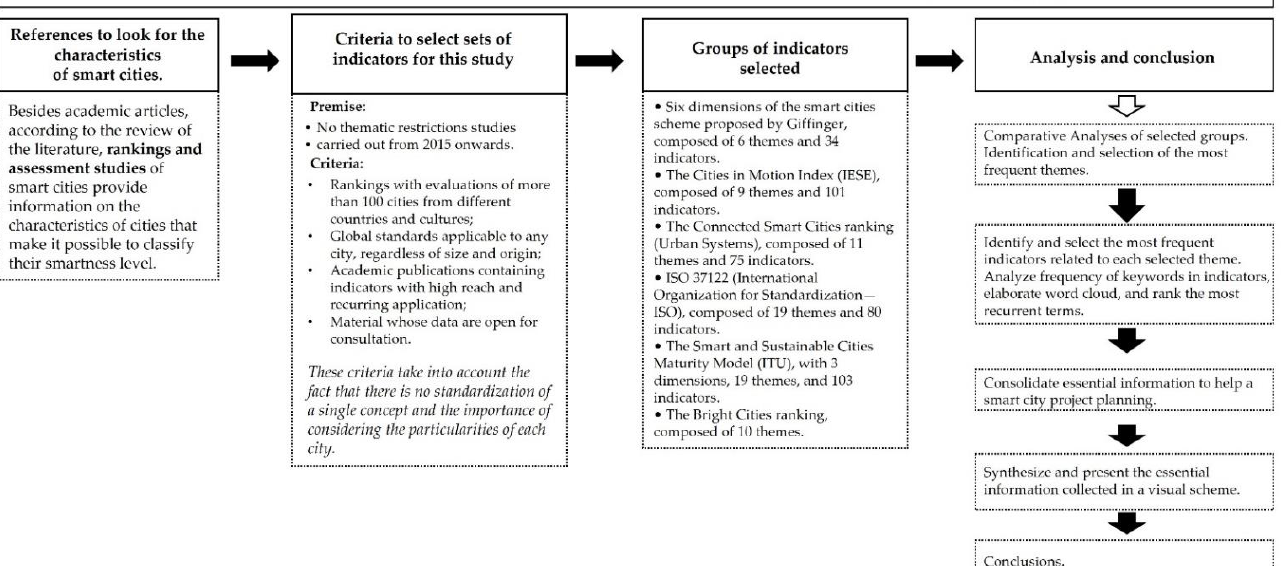
Figure 7. Smart cities ’ dimensions and indicators according to Giffinger. Source: [35]. Adapted by the author.